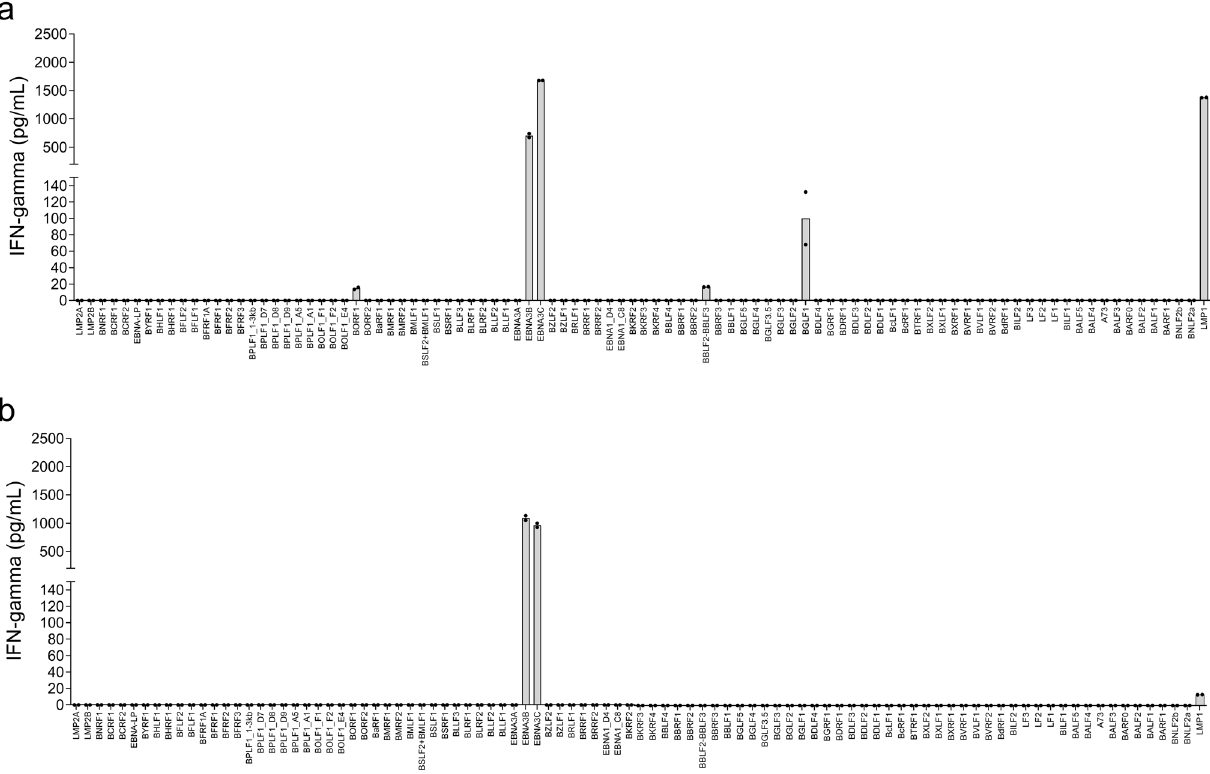
Fig. 3 Representative data from donor 2 for IFN γ release by EBV-speci fi c lines stimulated and expanded with moDC plus LCLs. IFN γ secretion was measured after co-culture of polyclonal CD8 + T cells with Cos7 cells individually expressing each EBV ORF in combination with HLA-B*57:01. EBV ORFs are arrayed along the x -axis in the order of their location in the EBV genome. The values on the y -axis represent IFN γ concentration in pg/mL. IFN γ concentration was extrapolated from a standard curve run with each assay. IFN γ release less than the lowest IFN γ standard used in the study, 12.5 pg/mL, is represented as 0. a Mean IFN γ concentration from T DC + LCL following duplicate transfection, and ( b ) Mean IFN γ concentration from T DC + lyLCL following duplicate transfection. Bars represent mean IFN γ concentration; dots are individual data points.